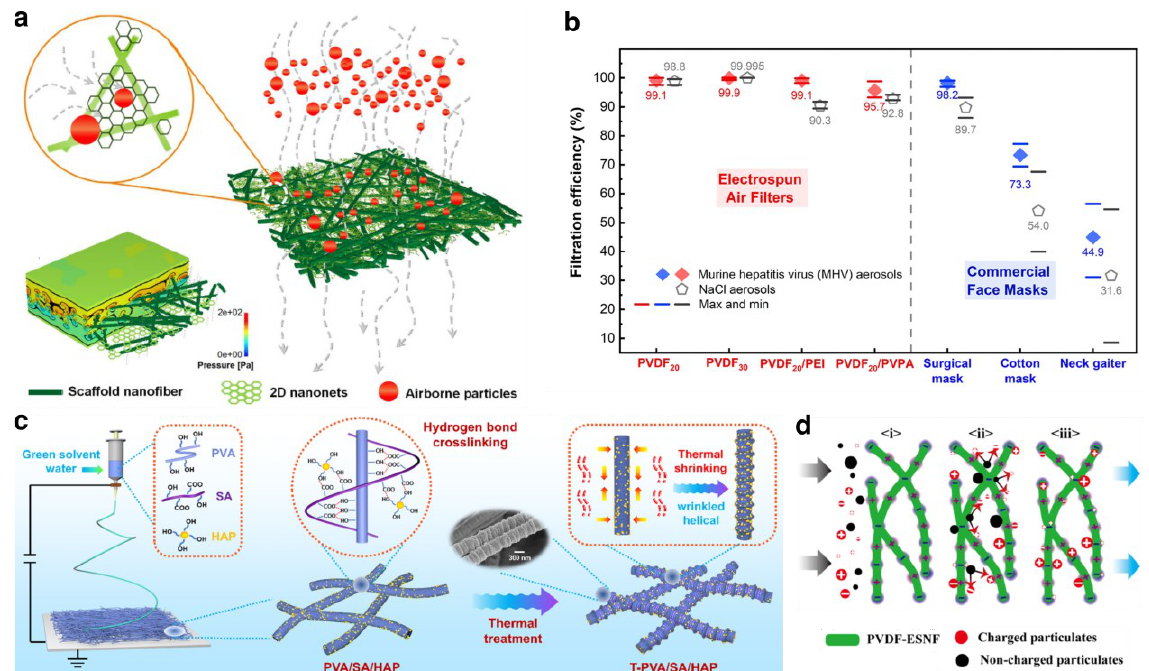
Figure 4. Nanofibrous mat prepared by electrospinning for filtration: ( a ) Filtration works with physical sieving (Adapted and reproduced with permission from Ref. [65]. Copyright 2017, Springer Nature); ( b ) Electrospun air filters have eminently better performance than commercial face masks (Reprinted with permission from Ref. [96]. Copyright 2017, American Chemical Society); ( c ) Sec- ondary structure of helical wrinkled nanofibers introduced by electrospinning (Reproduced with permission from Ref. [66]. Copyright 2022, Elsevier B.V.); ( d ) Self-powered facemask based on elec- trospun triboelectric nanogenerator (Adapted and reproduced with permission from Ref. [35]. Cop- yright 2018, American Chemical Society).